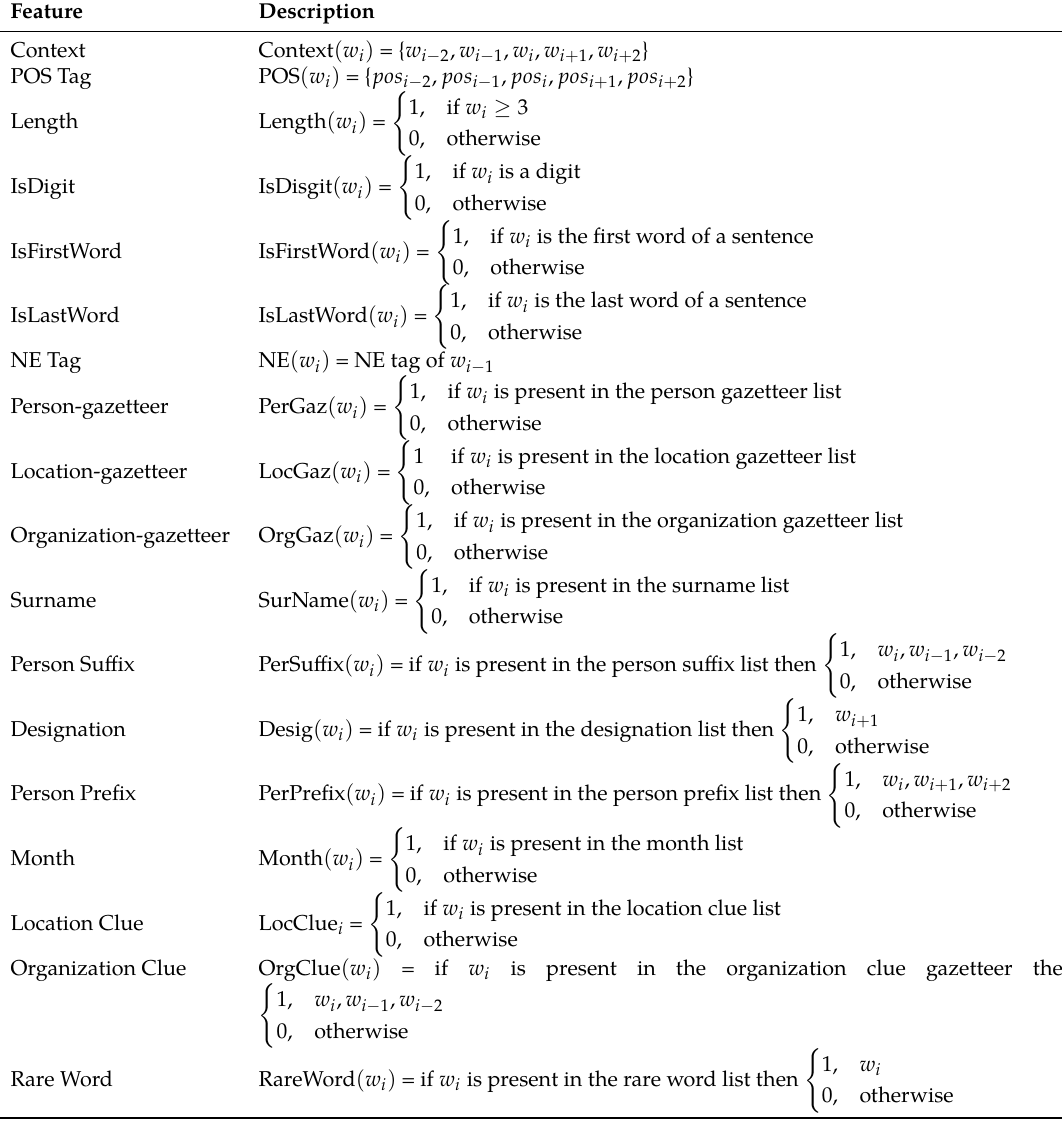
Table 4. Features. POS: part-of-speech.